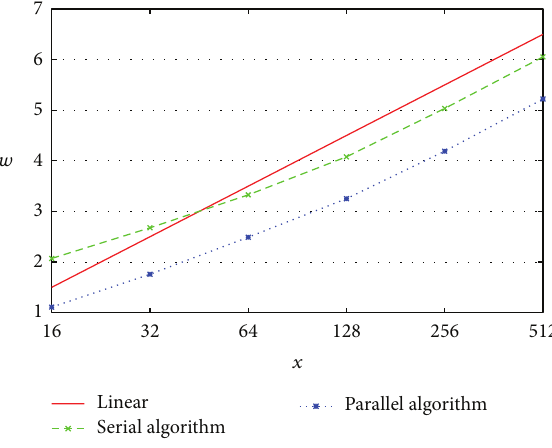
Figure 10: The linear variation of 𝑤